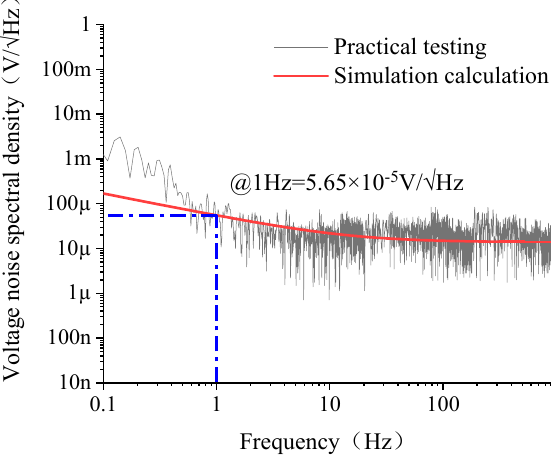
Figure 6. Voltage noise spectral density curve of the GMI sensor.